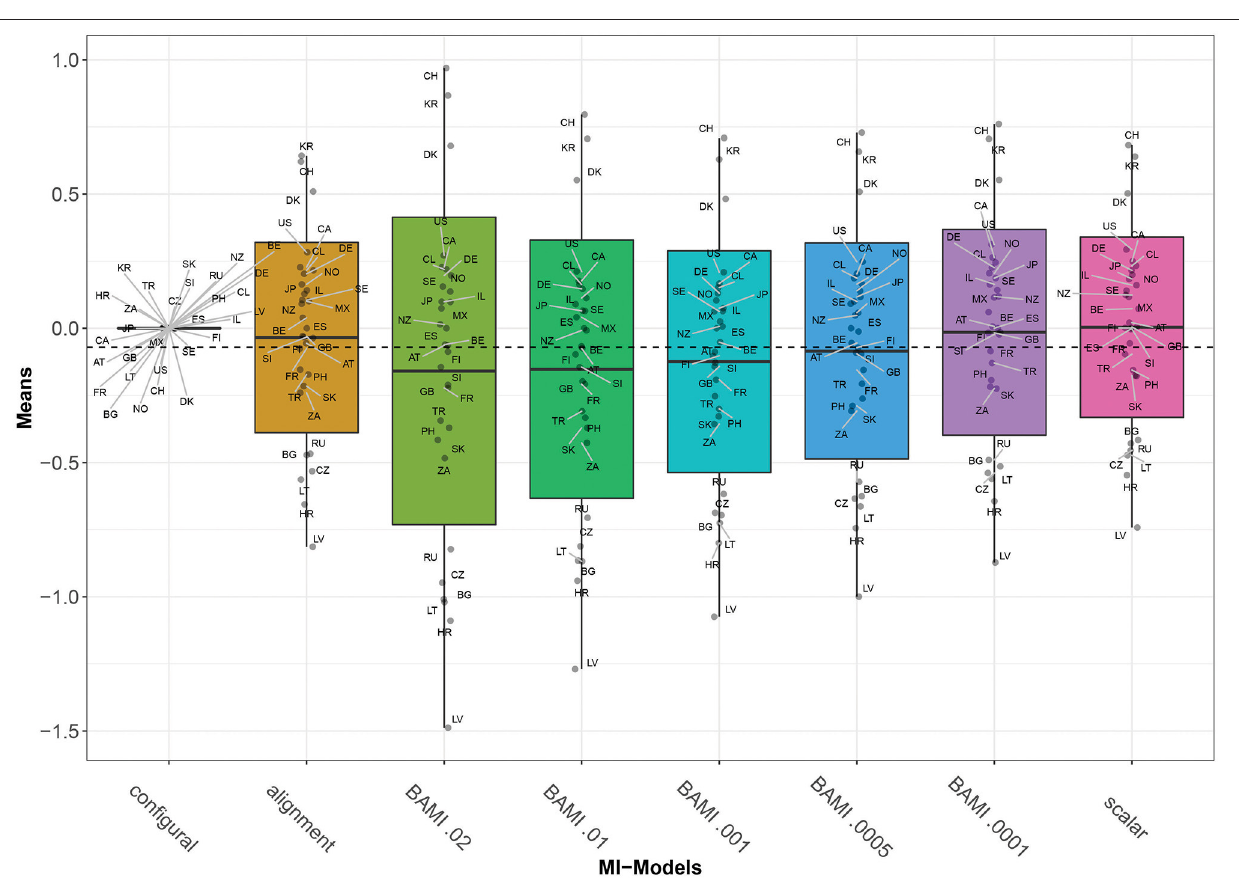
FIGURE 1 | Means for configural invariance, scalar invariance, ML alignment, and BAMI models. AT, Austria; BE, Belgium; BG, Bulgaria; CA, Canada; CL, Chile; HR, Croatia; CZ, Czech Republic; DK, Denmark; FI, Finland; FR, France; DE, Germany; GB, Great Britain; IL, Israel; JP, Japan; LV, Latvia; LT, Lithuania; MX, Mexico; NZ, New Zealand; NO, Norway; PH, Philippines; RU, Russia; SK, Slovakia; SI, Slovenia; ZA, South Africa; KR, South Korea; ES, Spain; SE, Sweden; CH, Switzerland; TR, Turkey; US, United States. The x-axis shows the different models—configural, scalar, ML alignment, and BAMI—with their specific variances. The dashed black line shows the overall